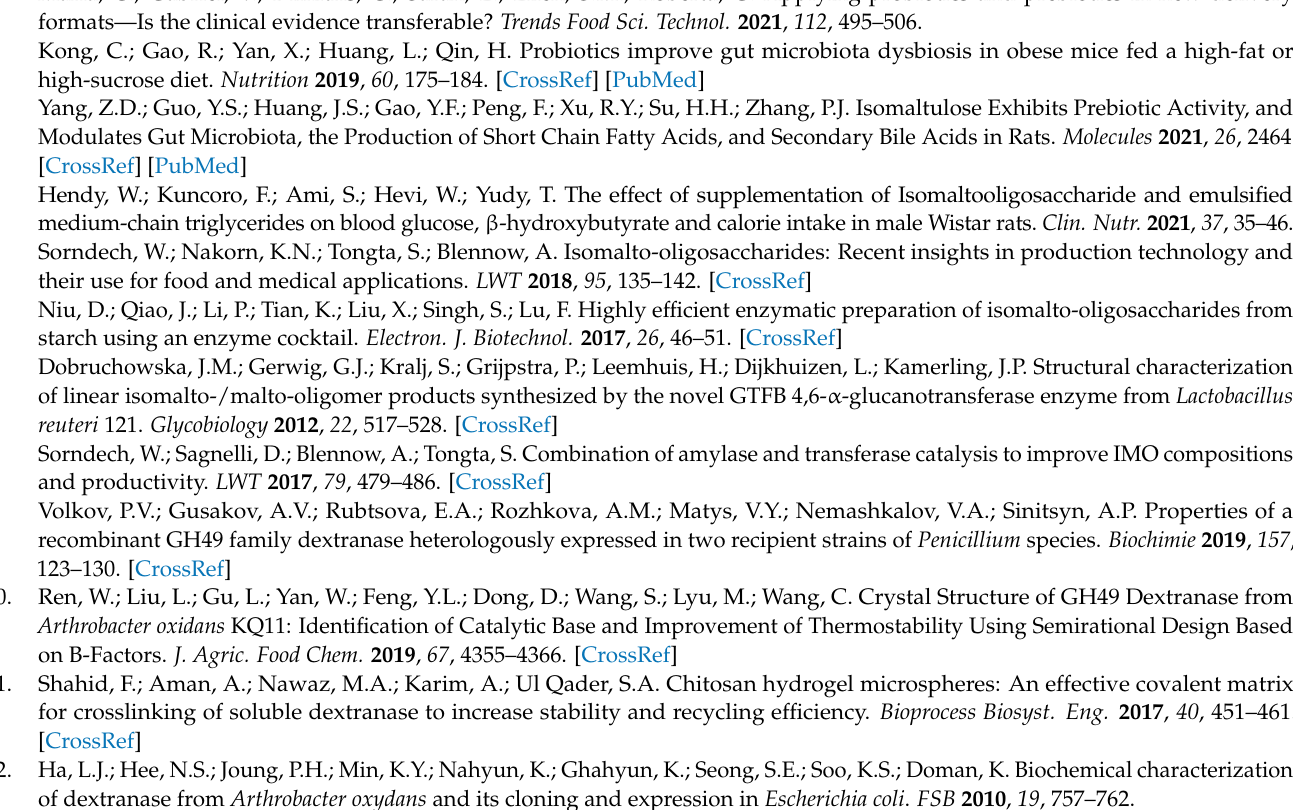
Figure S2: Expression conditions of PsDex1711. (a) The effect of IPTG concentration on PsDex1711 expression; (b) The effect of temperature on PsDex1711 expression; (c) The effect of time on PsDex1711 expression; Table S1: Analysis of different components in commercial